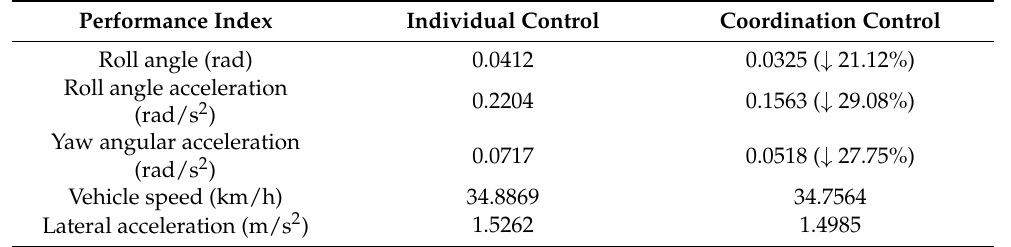
Table 7. RMS value of the performance index.